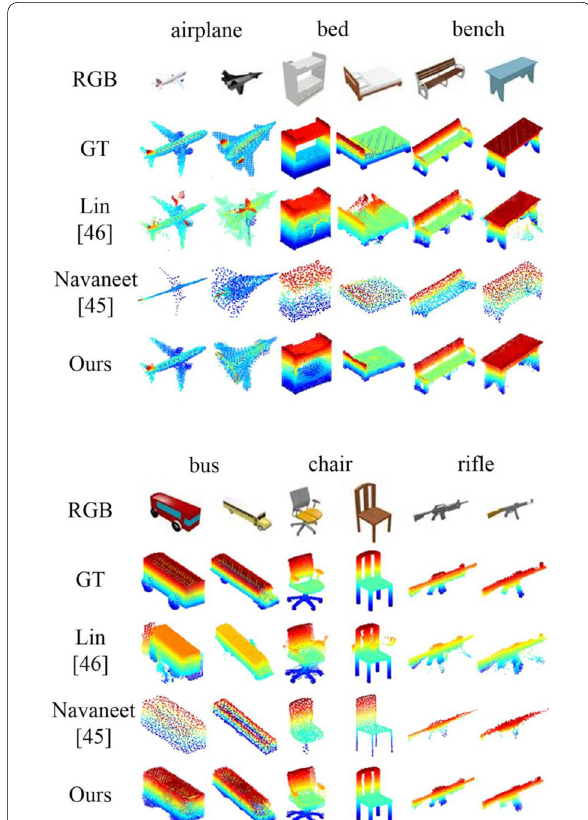
Figure 11 Multi-class reconstructed point clouds